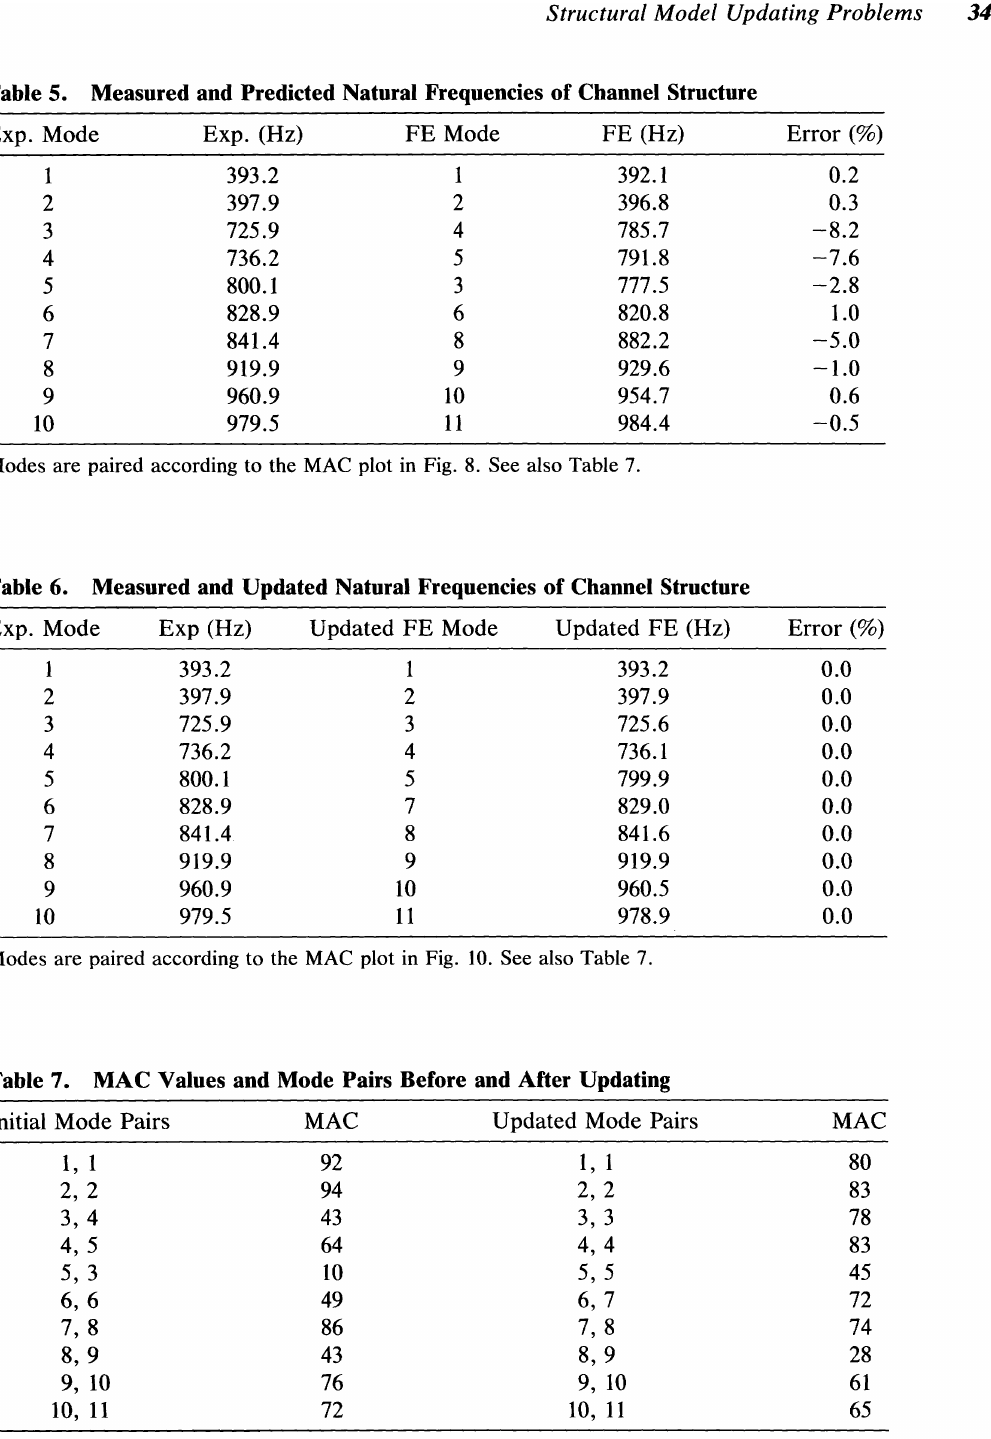
Table 8. Initial and After Updating Norms